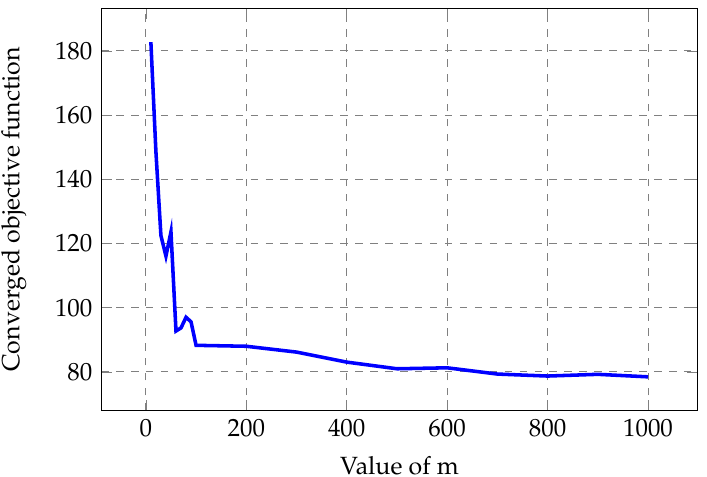
Figure 2. SA converged objective function value versus value of m for the cantilever beam prob- lem with volume fraction 0.5 ( m is the number of objective function evaluations to reach thermal equilibrium in a specific